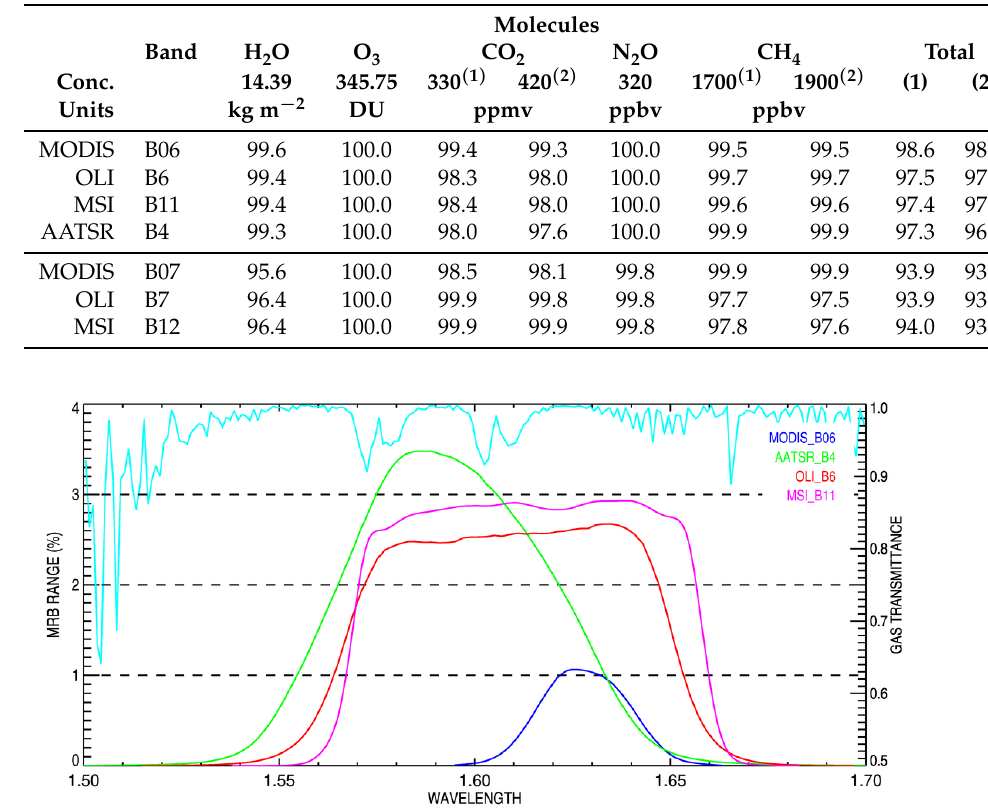
Table 2. Molecular atmosphere’s weighted average transmittance in percent for the spectral bands in the SWIR1 and SWIR2 regions listed in Table 1. The weighting function is the corresponding sensor spectral response. Transmittance values are given for the mid-latitude summer vertical profile. The last column corresponds to the total average transmittance. (1) Original CO 2 and CH 4 concentration (Conc.) values after [10]. (2) Current concentration values.